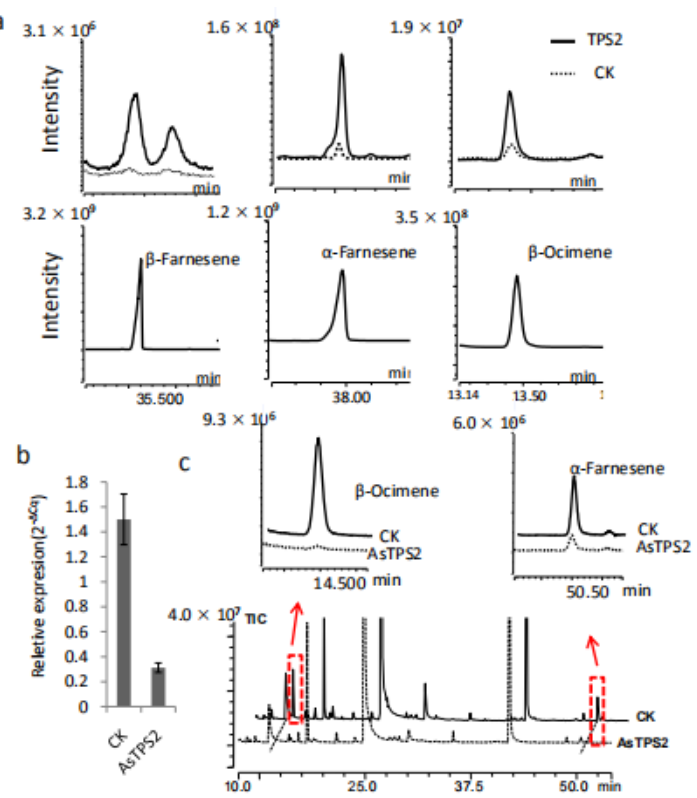
Figure 6. Functional characterization of TPS2 in vitro and in plants. ( a ) β -Farnesene, α -Farnesene and β -Ocimene produced by TPS2 using FPP and GPP as substrates respectively. ( b ) The expression level of TPS2 was reduced after treated with AsODN- TPS2 and change in the abundance of α -Farnesene and β -Ocimene in tea treated with AsODN- TPS2 (highlighted by the red boxes and arrows) ( c ).